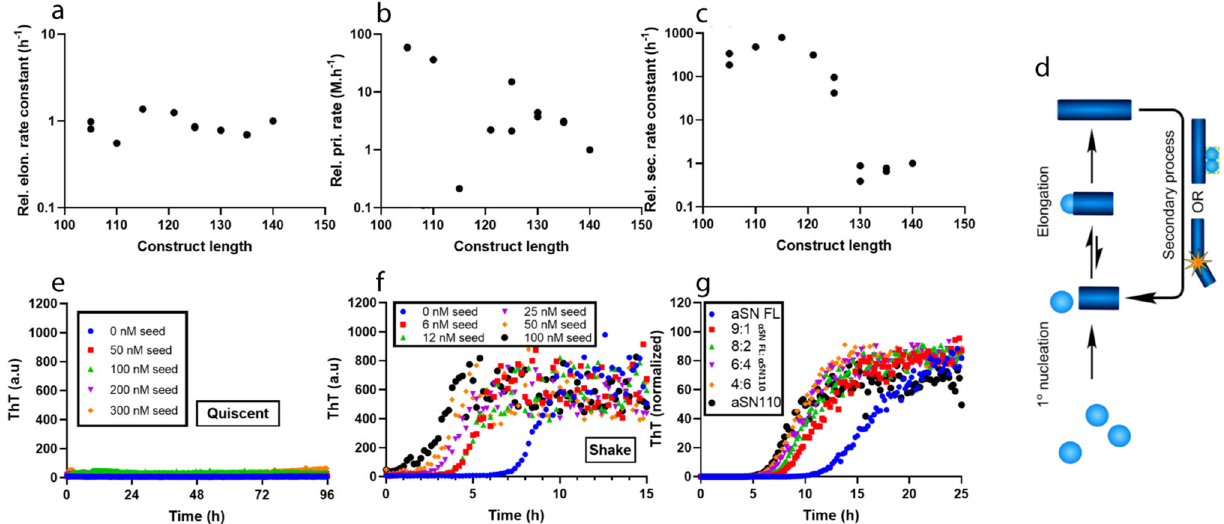
Fig. 2 Determination of individual rate constants of fi brillation for α SN truncated mutants. a Relative elongation rate constant, k + , rel , obtained from seeded experiments shown in Fig. S6. There is little variation with length under the assumption that the length of the seed fi brils is similar for different truncation lengths. Details in Eq. 3. b The rate of primary nucleation, evaluated from the rate constant, k n , and reaction order, n c . Values calculated at 50 µ M α SN to enable comparison between variants with varying reaction orders. c Rate constant of fragmentation, k - , versus construct length. There is a very abrupt decrease between α SN125 and α SN130. Each data point in a – c corresponds to a separate experiment with three repeats in three wells; α SN 105, α SN 125, aSN 130, and α SN 135 were randomly repeated. d Schematic reaction network with an explicit two-step mechanism for elongation. e , f Low-seed (0.03, 0.06, 0.1, 0.2%) fi brillation without ( e ) and with ( f ) shaking shows that shaking strongly promotes fi brillation. Data are for α SN121. ( g ) ThT fi brillation of different mixtures of α SN-FL and α SN110 (total protein concentration of 100 µ M). Note that as little as 10% α SN110 signi fi cantly reduces the lag time. Shaking conditions in f , g are reduced to 1 min (instead of the 10 min used for the other shaking experiments) in 12-min measurement (Fig. S8j), leading to comparable yields of the main component oligomer (eluting around 12 ml) in all cases.